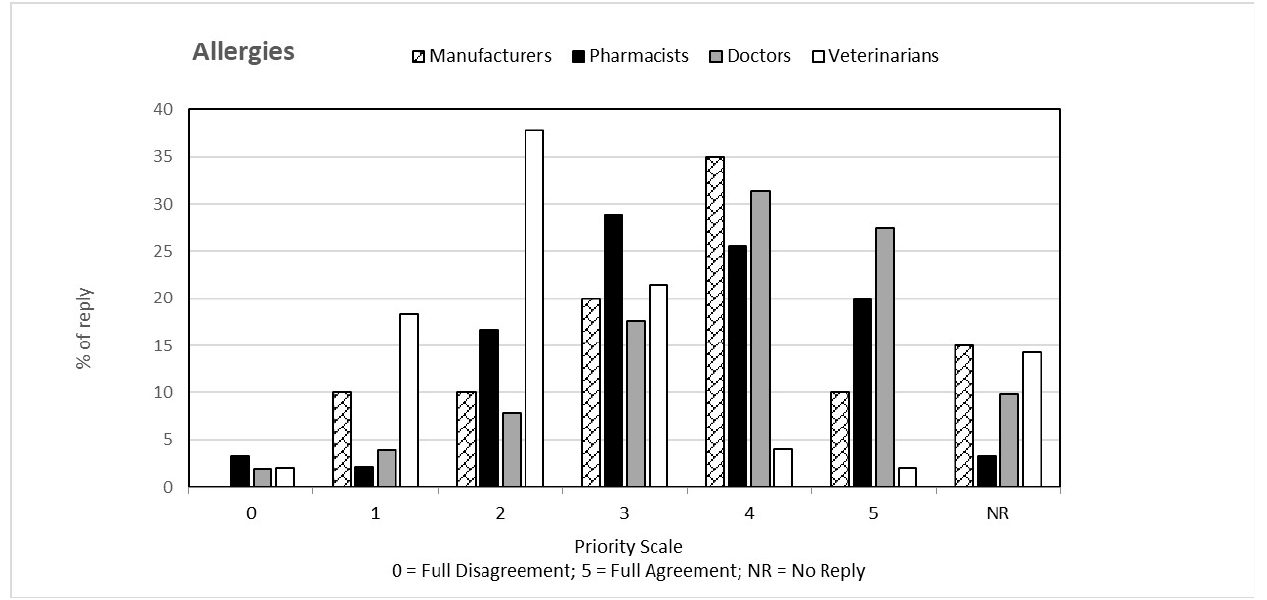
Figure 4. Percentage of answers “ALLERGIES” to the question “Global Environmental Changes manifest themselves with ....” given by the four interviewed categories. The tables also include the percentage of “no reply” (NR) responses.